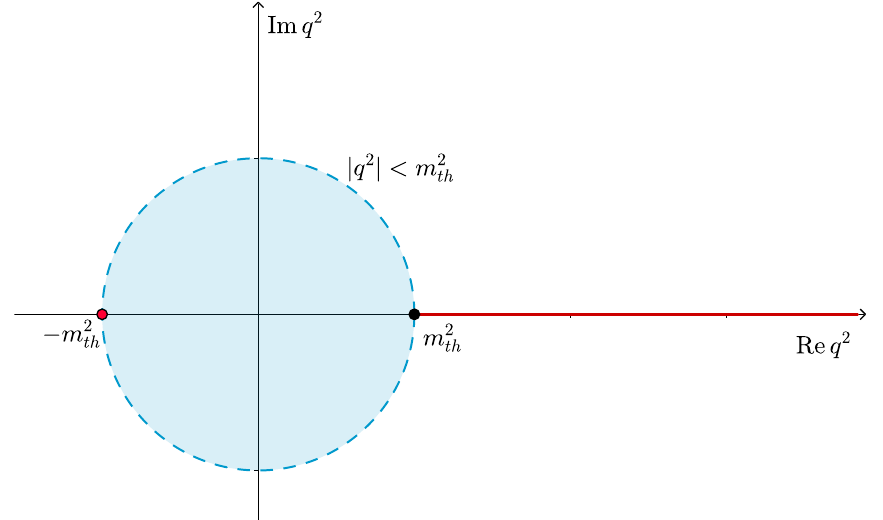
Figure 4 . Branch cut (red line) and domain of convergence (blue region) of the truncated propagator (3.13). Unstable ghosts of the full theory can only live in the branch cut region and cannot be detected within truncated derivative expansions of the effective action. Genuine and fake (stable) ghosts live in the principal branch of the logarithm, i.e., in the region Re q 2 < m 2 former stay inside the domain of convergence of the logarithm and are visible within truncations. The latter can only be generated outside of the domain of convergence, are only present within truncations, and they move towards and accumulate on the boundary of the domain of convergence of the form factor characterizing the full